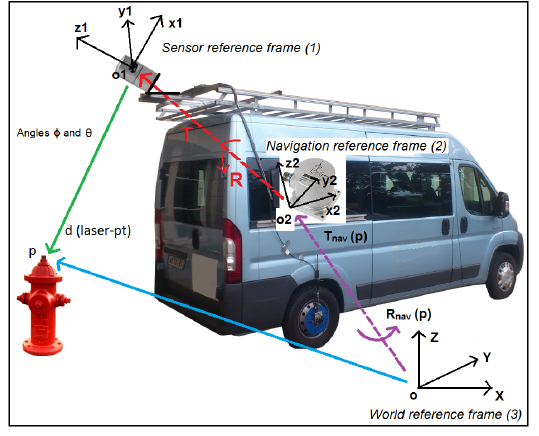
Figure 1: Geo-referencement of the data method. Section 4. shows some results obtained with our algo- rithm, and section 5. gives a conclusion to this